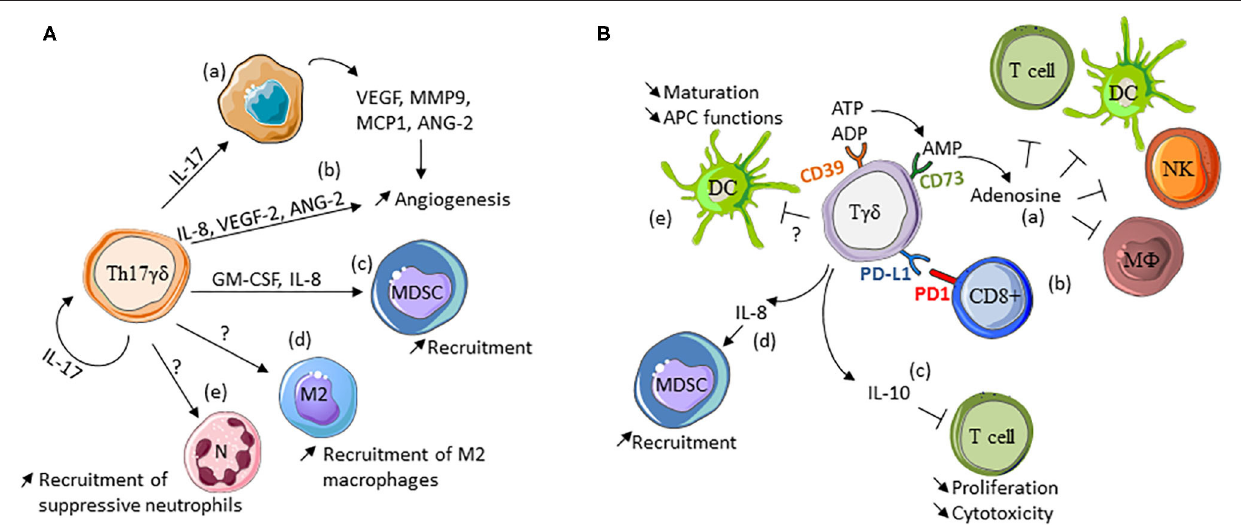
FIGURE 2 | Pro-tumor functions of γδ T cells. (A) Th17-like γδ T cells. Th17 γδ cells promote angiogenesis indirectly by inducing the production of angiogenic factors by cancer cells (a), or directly by producing angiogenic factors (b). They also induce myeloid-derived suppressor cell (MDSC) recruitment through GM-CSF and IL-8 production (c), and recruit or polarize M2 macrophages (d) and suppressive neutrophils (e). (B) Pro-tumor γδ T cells. CD39 + /CD73 + γδ T cells produce adenosine that inhibits αβ T cell proliferation and anti-tumor functions (a). γδ T cells can express PD-L1 and inhibit the function of PD1-expressing cells, such as CD8 + cells (b). IL-10 produced by γδ T cells inhibits CD8 + cell proliferation and cytotoxicity (c). They also favor MDSC recruitment via IL-8 (d) and inhibit dendritic cell (DC) maturation and functions through not identified mechanisms (e). NK, natural killer cells; M φ , macrophages, APC, antigen-presenting